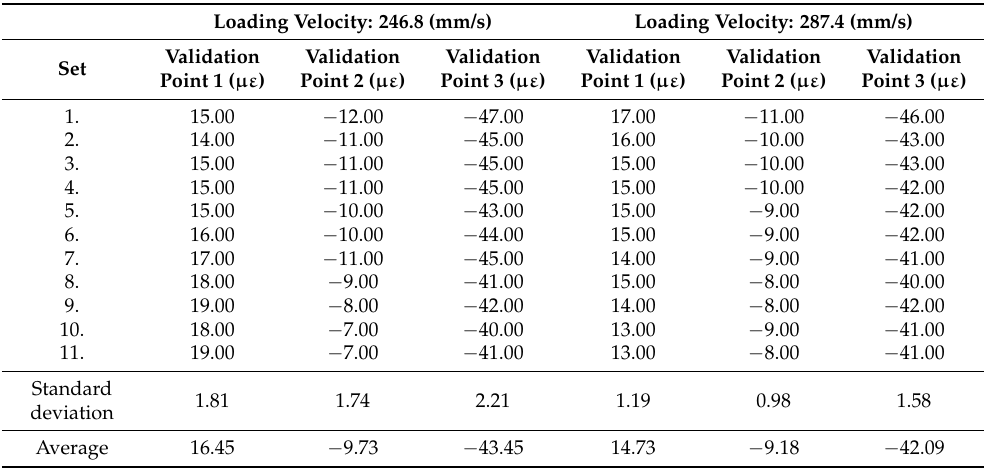
Table 5. Steady state strain of validation points measured in 11 sets of experiments for two loading